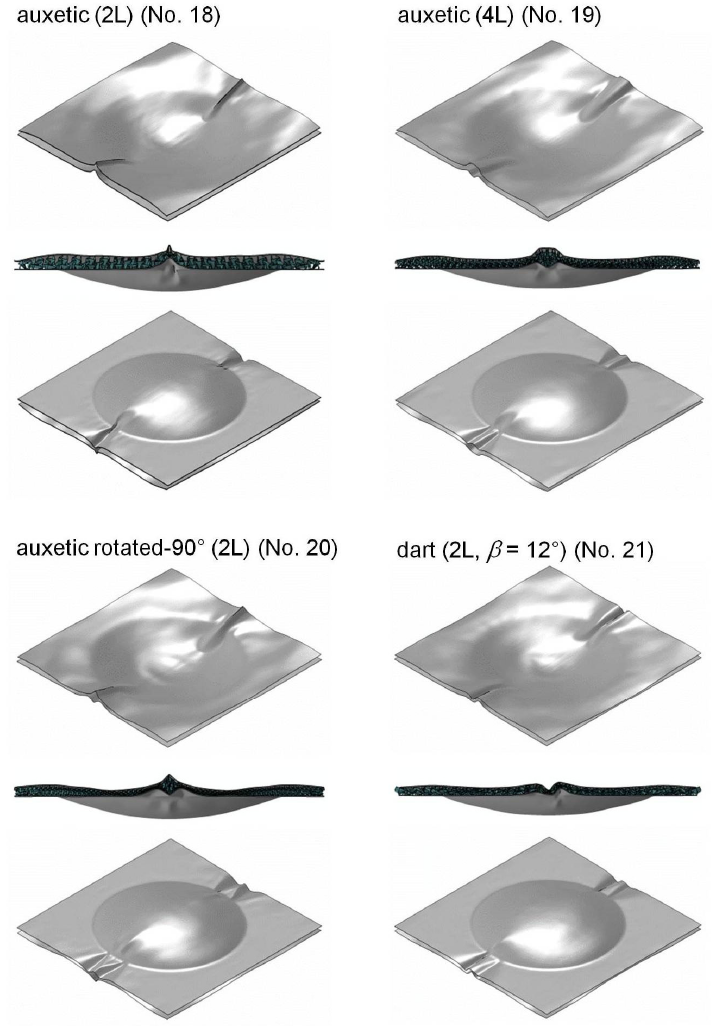
Figure A6. Deformation states of the top and bottom sides for prismatic, multi-layered, auxetic cores No. 18–21 subjected to air-blast loading (t = 0.6 ms).